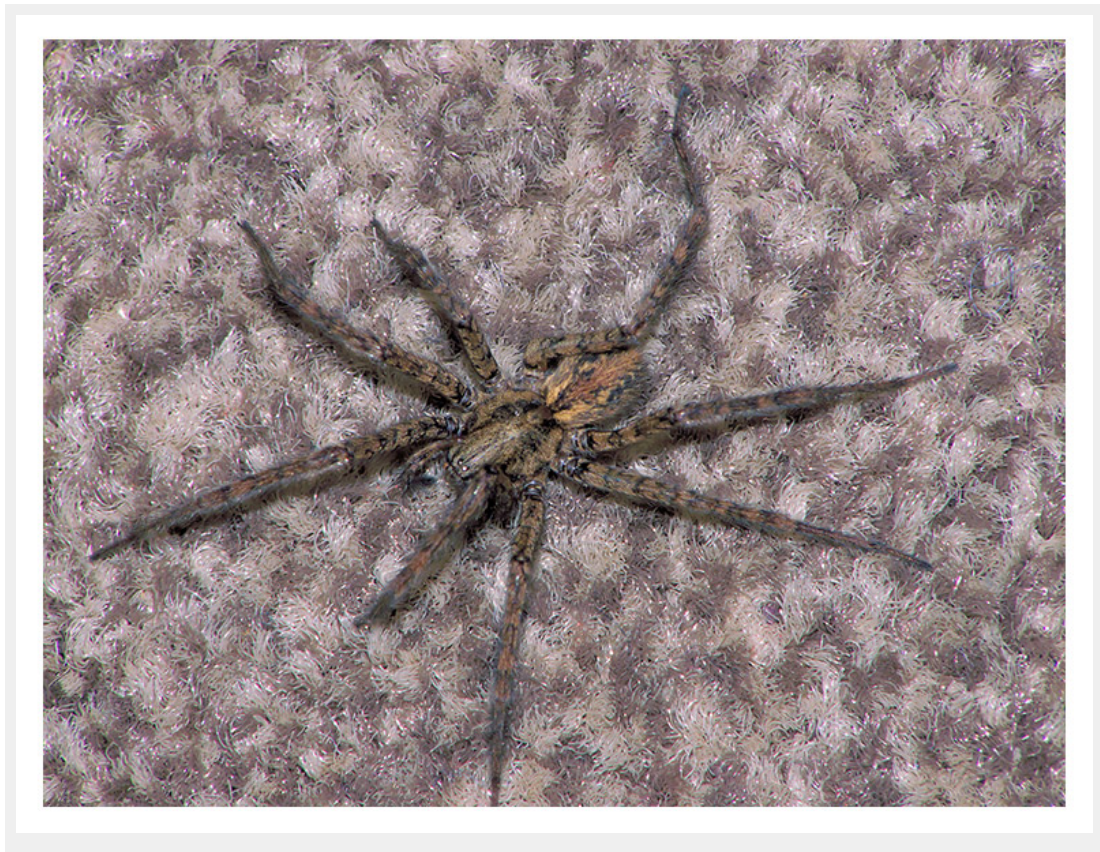
Figure 6 Malthonica ferruginea (source: Rasbak, Wikimedia